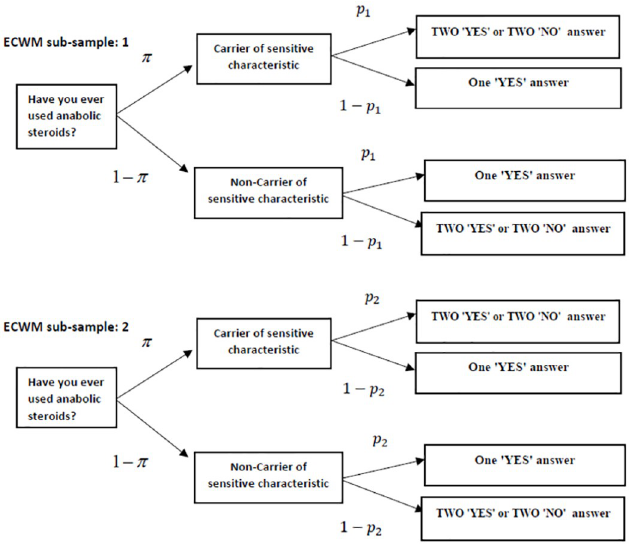
Fig 1. Diagram of the ECWM [26], with π denoting the prevalence of the sensitive characteristic, and p 1 and p 2 , for p 1 + p 2 = 1, the probabilities of answering “Yes” to the unrelated question in sub-samples 1 and 2.